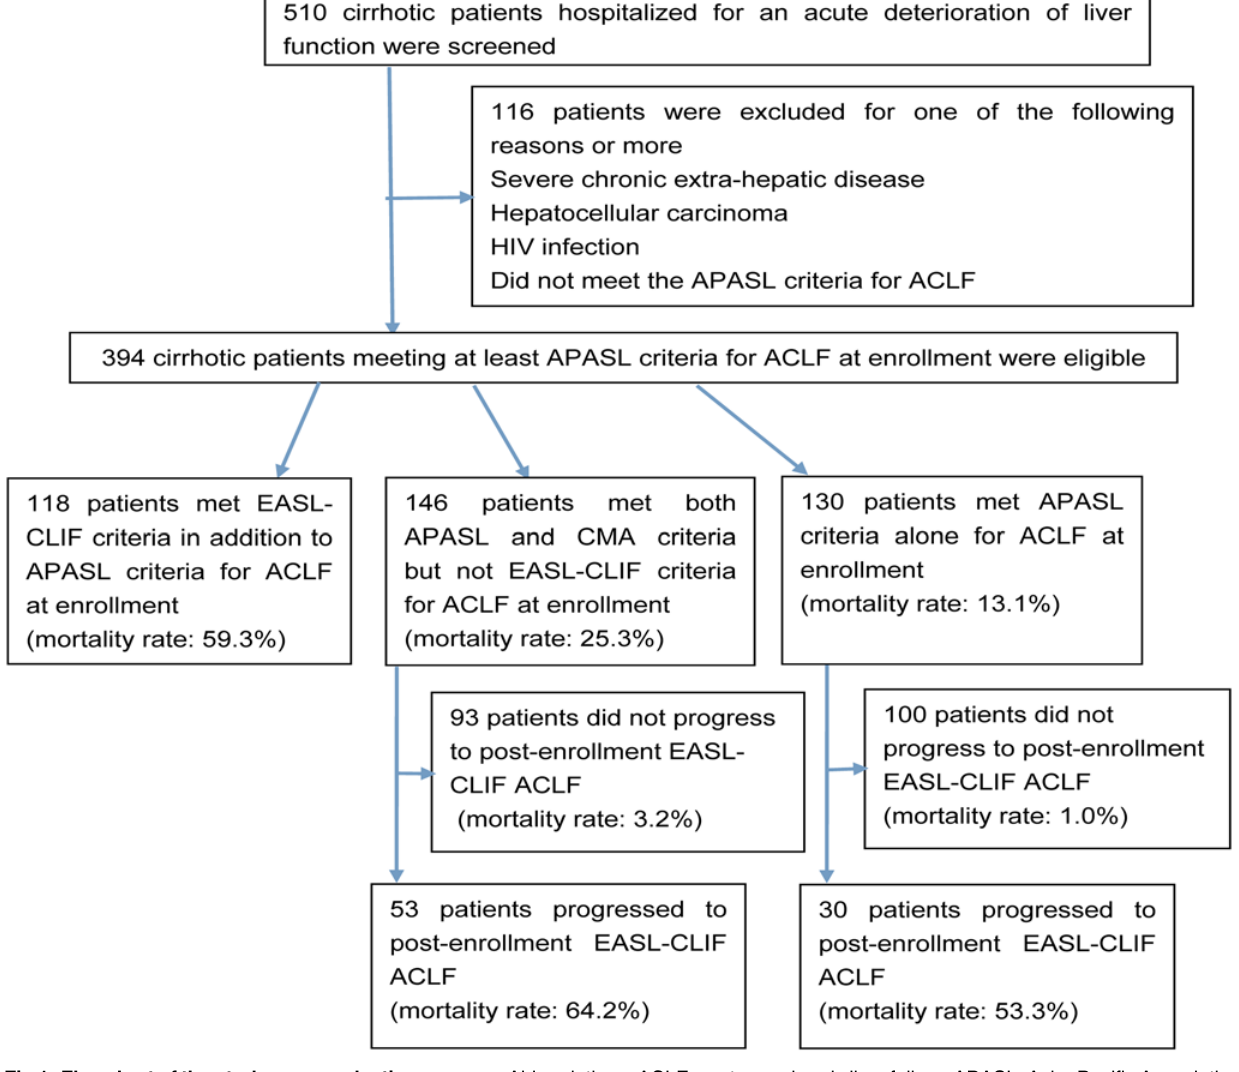
Fig 1. Flowchart of the study group selection process. Abbreviations: ACLF, acute-on-chronic liver failure; APASL, Asia – Pacific Association for the Study of the Liver; CMA, Chinese Medical Association; EASL-CLIF, EASL-Chronic Liver Failure.